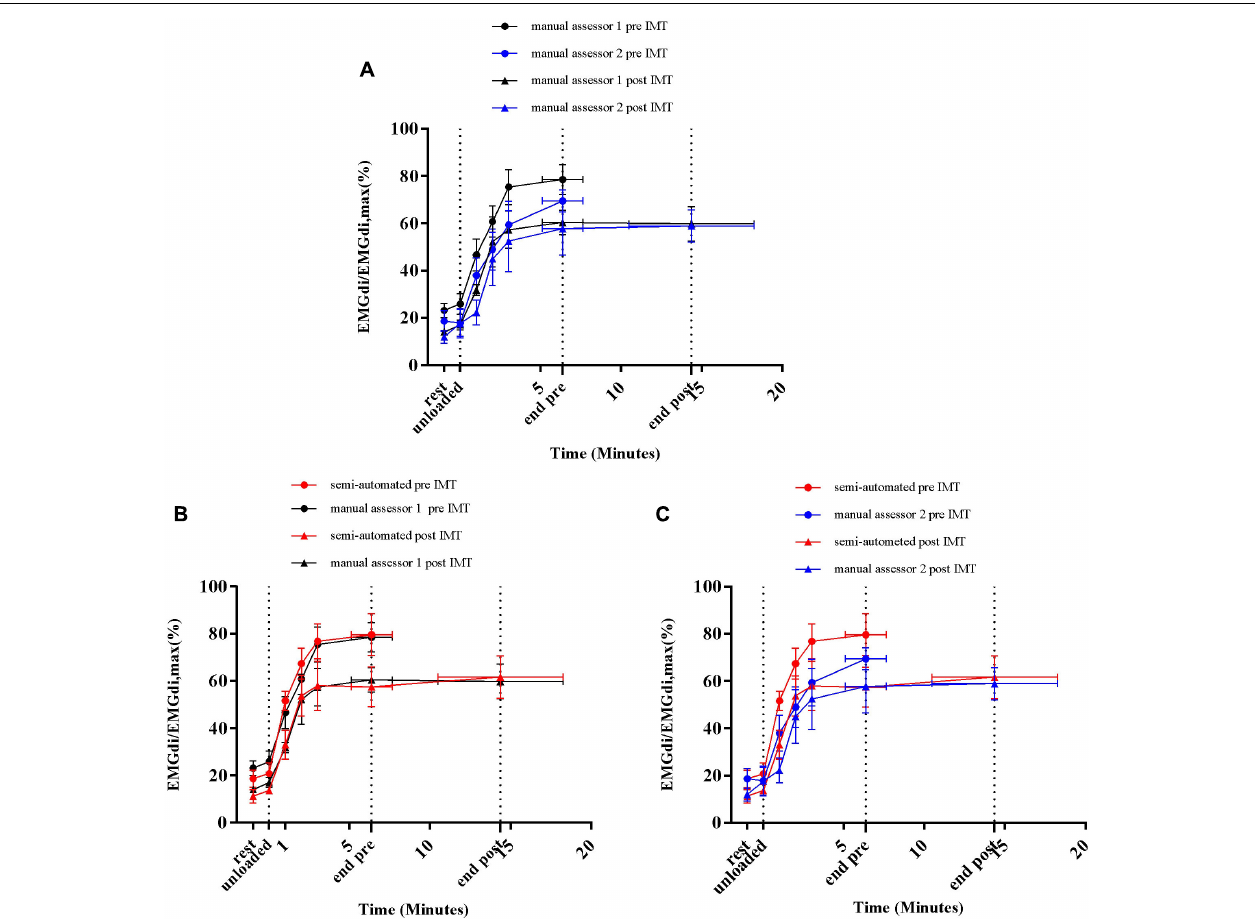
FIGURE 9 | Average diaphragm activation (EMGdi/EMGdiMax%) of four patients during CWR cycling test pre and post the intervention calculated from the manual method by two assessors (A) ; the semi-automated method and the manual method by assessor 1 (B) ; the semi-automated method and the manual method by assessor 2 (C)